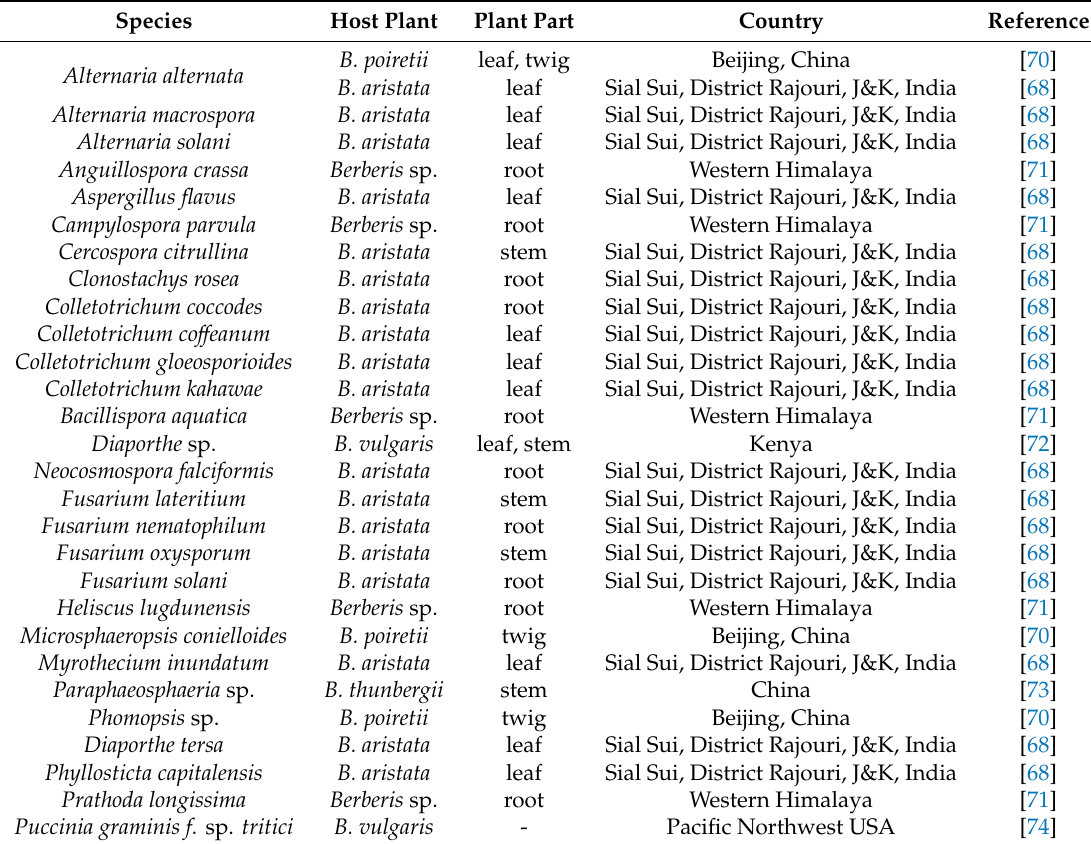
Table 5. Endophytic fungi isolated from Berberis